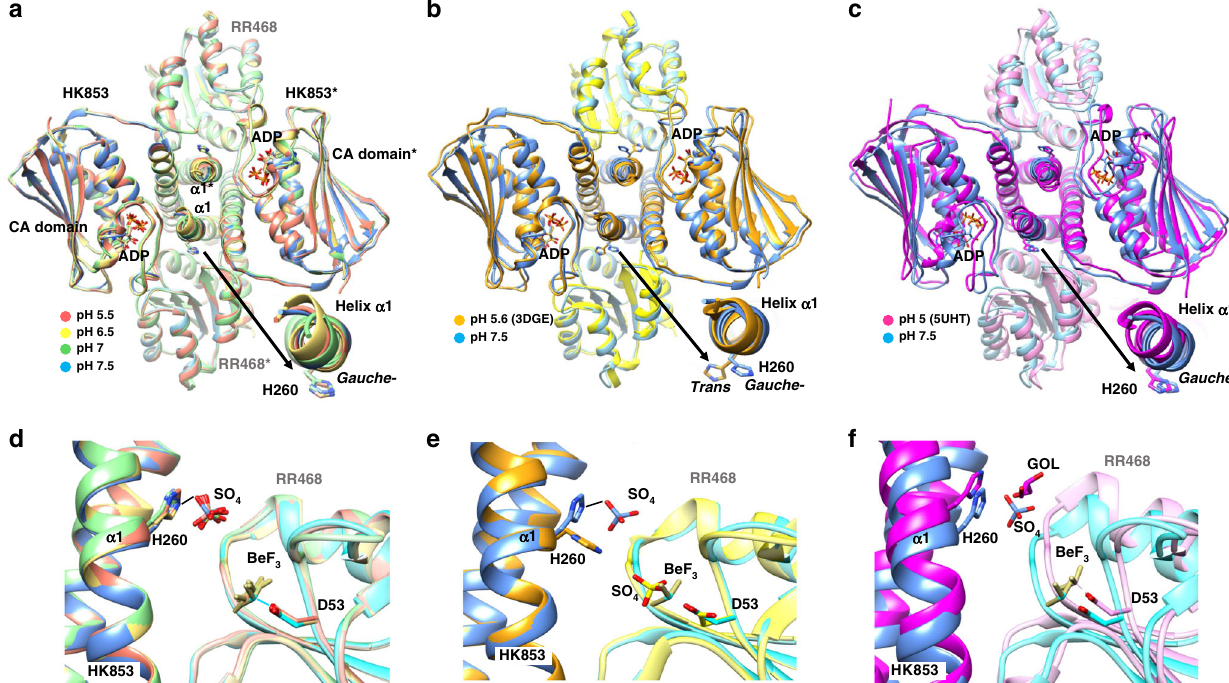
Fig. 2 Structures of the wild-type complex of HK853 – RR468 at different pHs. a Superposition of HK – RR pHs structures. The complexes composed of a dimeric HK853 bound to two molecules of RR468 (the asterisk denotes the second molecule) solved at pHs 5.5 (in salmon), 6.5 (yellow), 7 (green), and 7.5 (blue) are represented in cartoon with HKs and RRs in dark and pale hues, respectively. The HK phosphorylatable His (H260) in the helix α 1 of DHp domain and the ADP in the CA domain are shown in sticks colored by atom type with the carbons in the same color as the corresponding molecule. A close view of the H260 for one monomer is shown. b Superposition of HK – RR pH at pH 7.5 (blue tones) with HK853 – RR468 5.6 (orange-yellow tones) highlighting the gauche − and trans rotamers of the H260, respectively. c Superposition of HK – RR pH at pH 7.5 (blue tones) with HK853 – RR468 5.0 (magenta tones) highlighting the gauche − rotamer for H260. d Close view of the active centers for the superposition of HK – RR pHs structures. The sulfate ion (labeled as SO 4 ; the two negative charges of the anion have been omitted for clarity) interacting with the HK H260 and the phosphomimetic BeF 3 − bound to the phosphoacceptor D53 of RR468 are shown in sticks. Structures are colored by pHs following the same code as in a . e and f Close view of the active centers for the superposition of HK – RR pHs at pH 7.5 (blue tones) with HK853 – RR468 5.6 (orange-yellow tones) in e and with HK853 – RR468 5.0 (magenta tones)